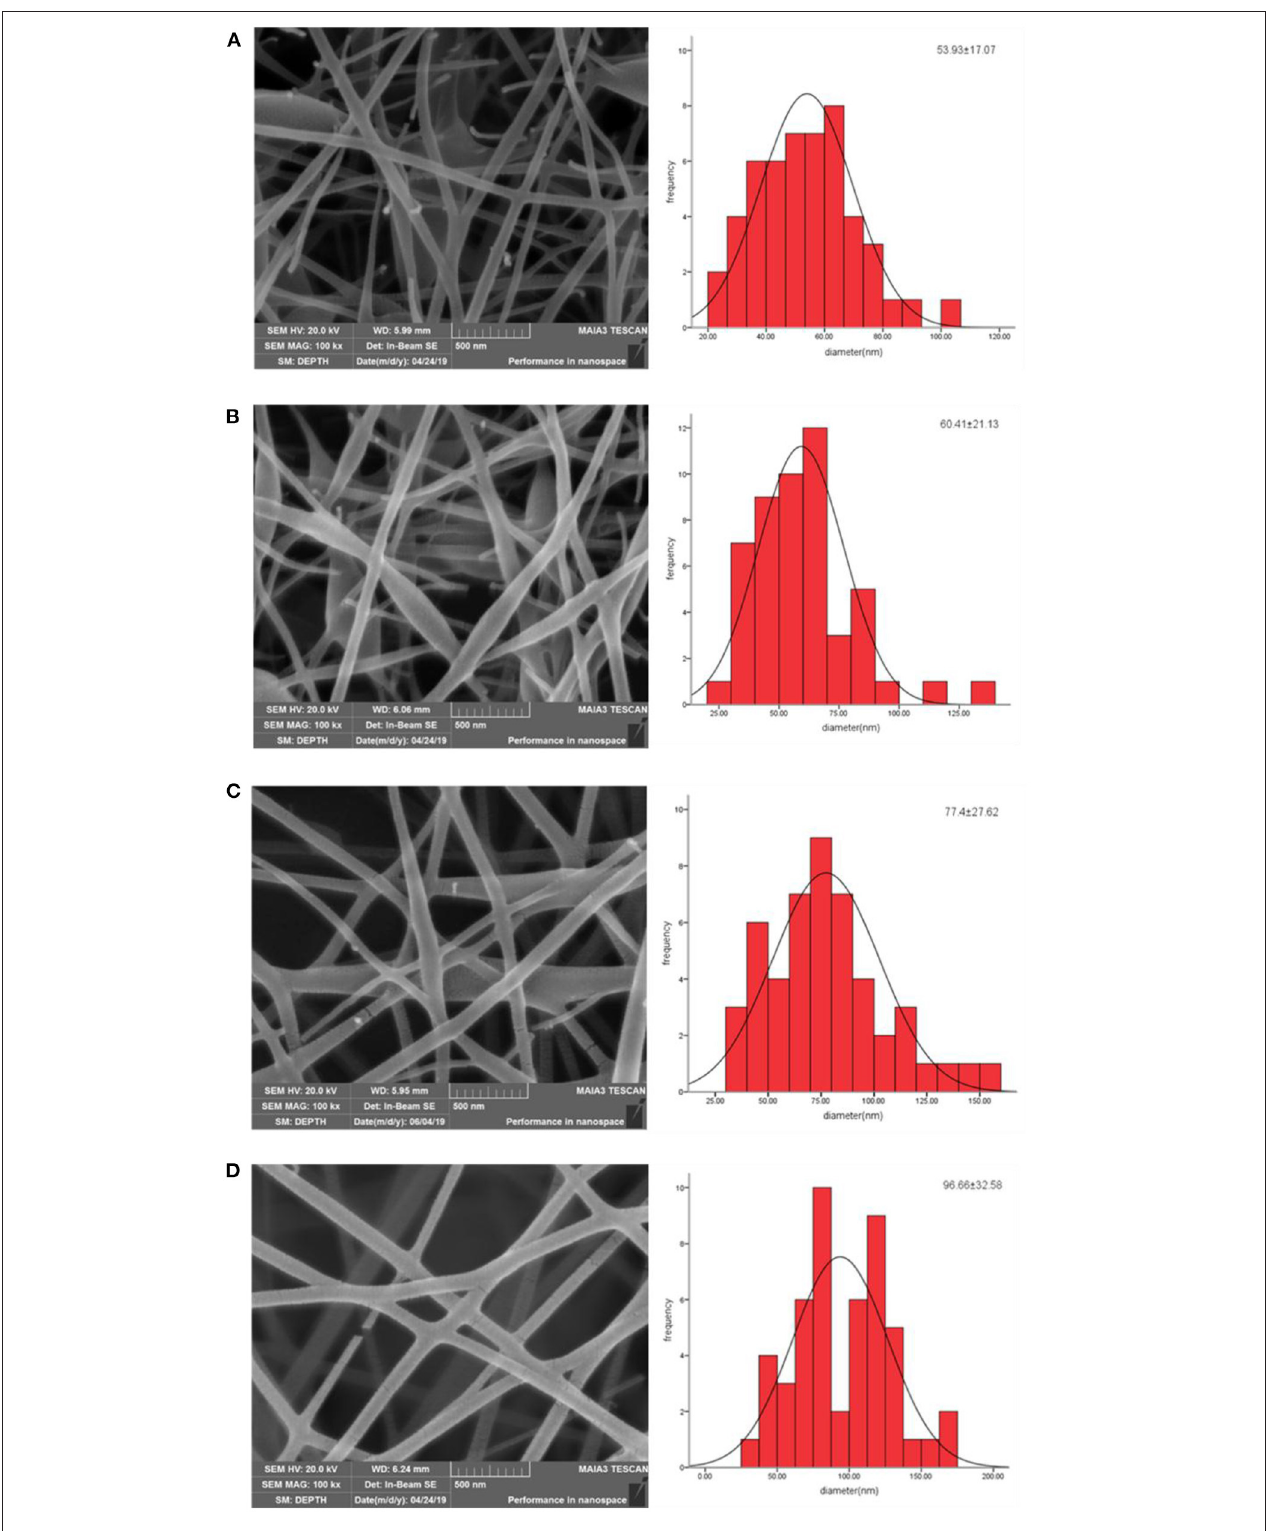
FIGURE 1 | SEM images and fiber diameter(nm) distribution of CS-PEO nanofibers prepared from various contents of NP10: (A) 0%, (B) 0.1%, (C) 0.3%, and (D) 0.5%.